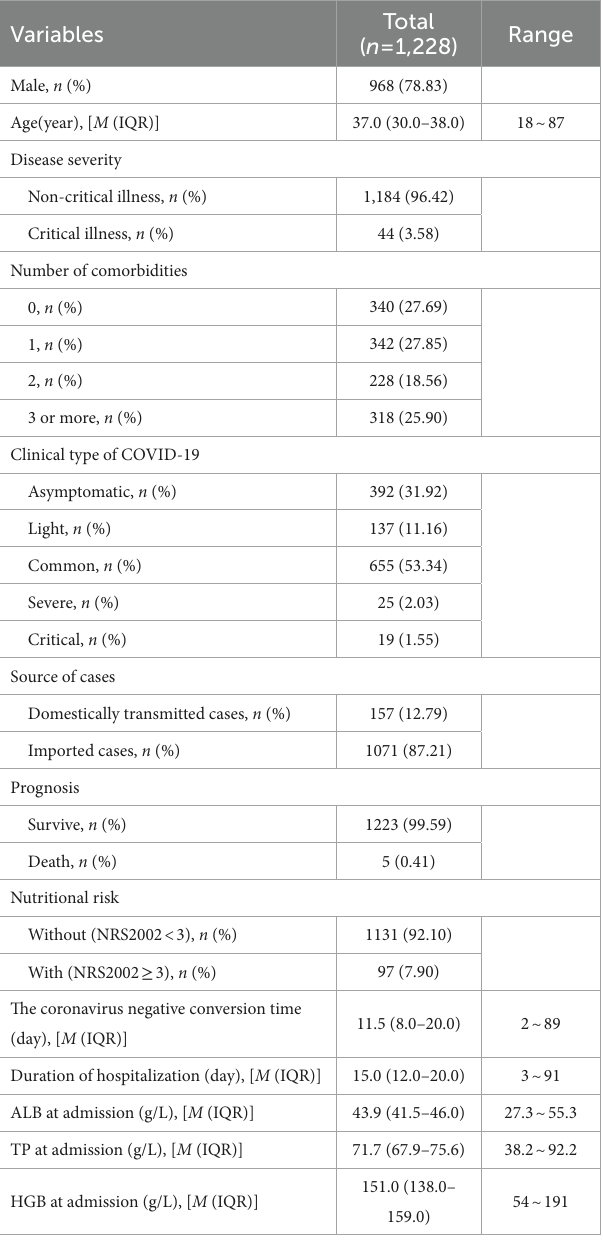
TABLE 1 Baseline characteristics of COVID-19